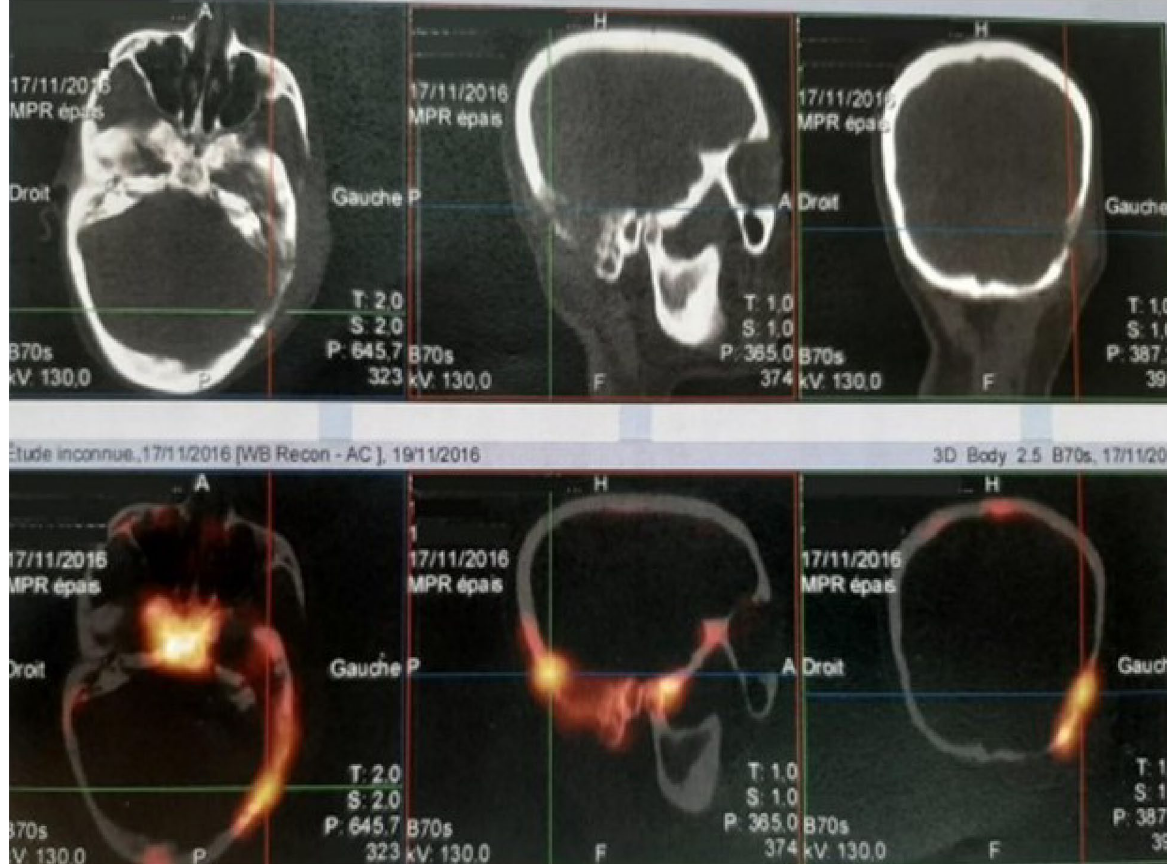
Fig. 2 SPECT-CT (Technetium-99) of the temporal bone showing high tissue activity of the tympanal and mastoid bones, spreading to the skull